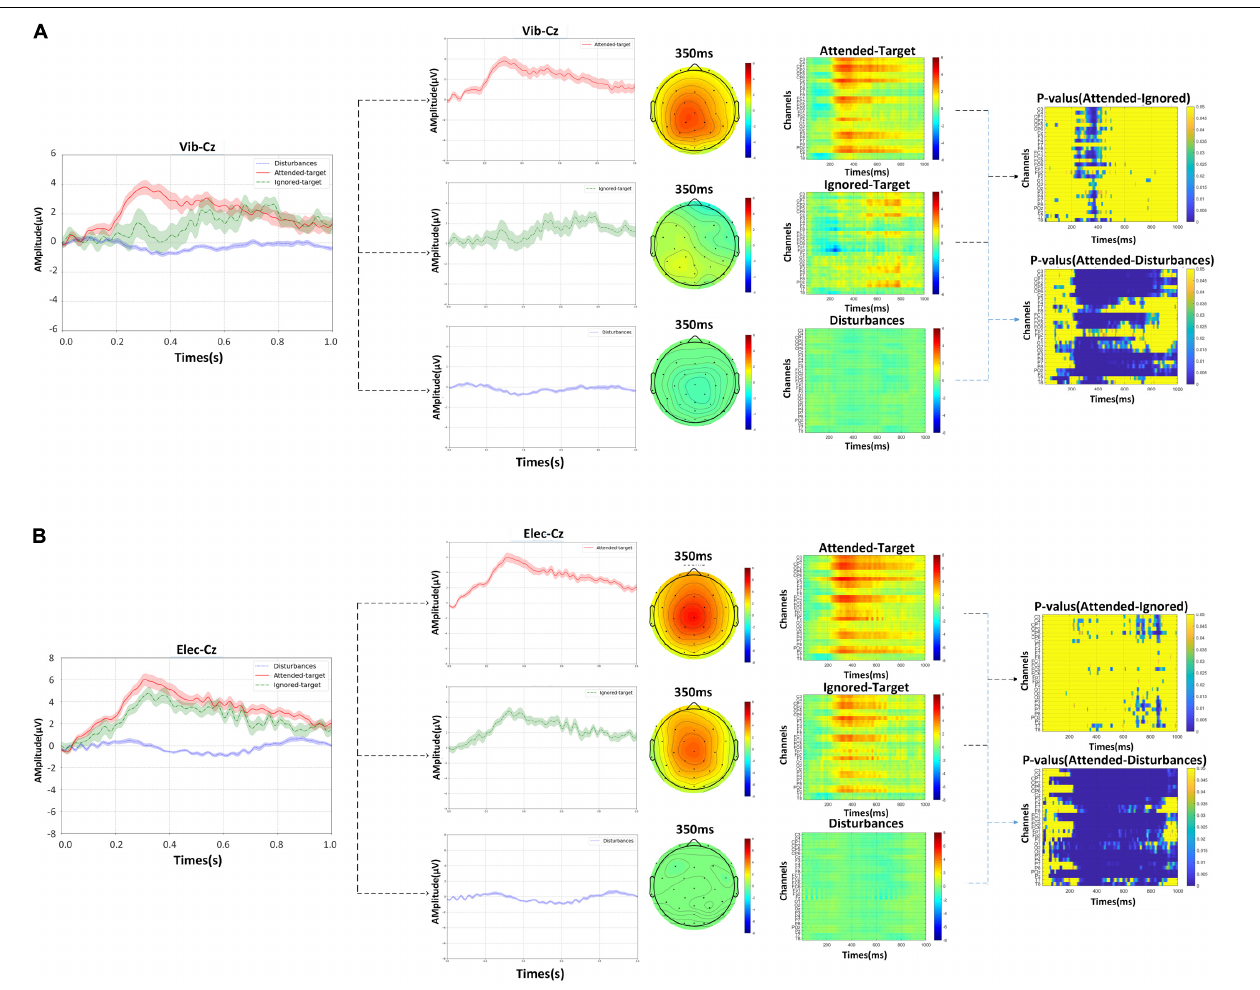
FIGURE 5 | The grand averaged waveforms with error-shaded bar (with the standard error), corresponding scalp topographies at a latency of 350 ms, the grand averaged ERPs responses from EEG channels for attended-targets, ignored-targets and disturbance stimuli at Cz over all subjects, and p -values of the amplitude differences between the ERPs of response to attended-target and ignored target stimuli as determined by the ANOVA: (A) the data of vibration, (B) the data of